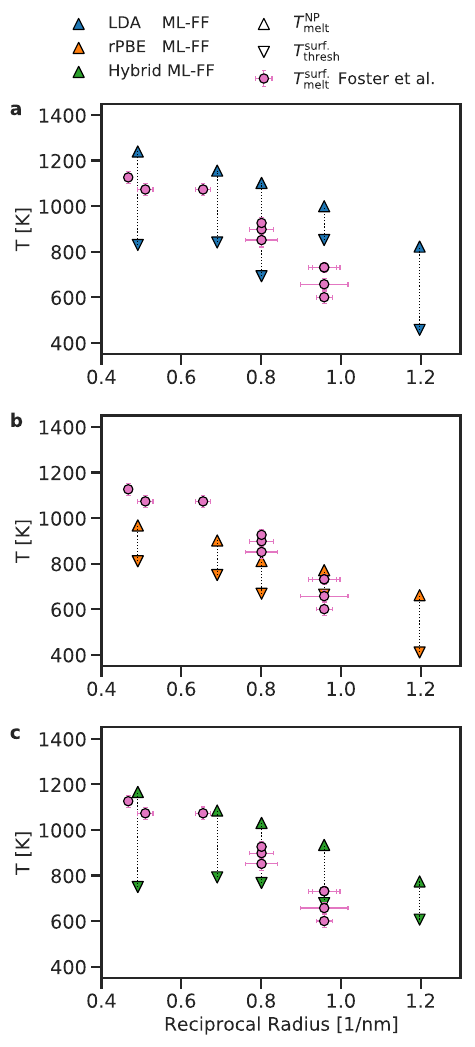
Fig. 4 Surface phase change temperatures of Au NPs of different sizes. T surf : (downward triangles) and T NP (upward triangles) as a function of melt melt NPs' reciprocal radius, for MD simulations carried out using the LDA ML-FF ( a ), rPBE ML-FF ( b ), and hybrid ML-FF ( c ). Experimental estimates of T surf : melt from high-resolution TEM measurements are taken from Foster et al. 38 , and are shown as pink circles. Error bars indicate the standard deviation of the melting temperatures and of the NP sizes for experimental data taken from Foster et al. 38 (pink